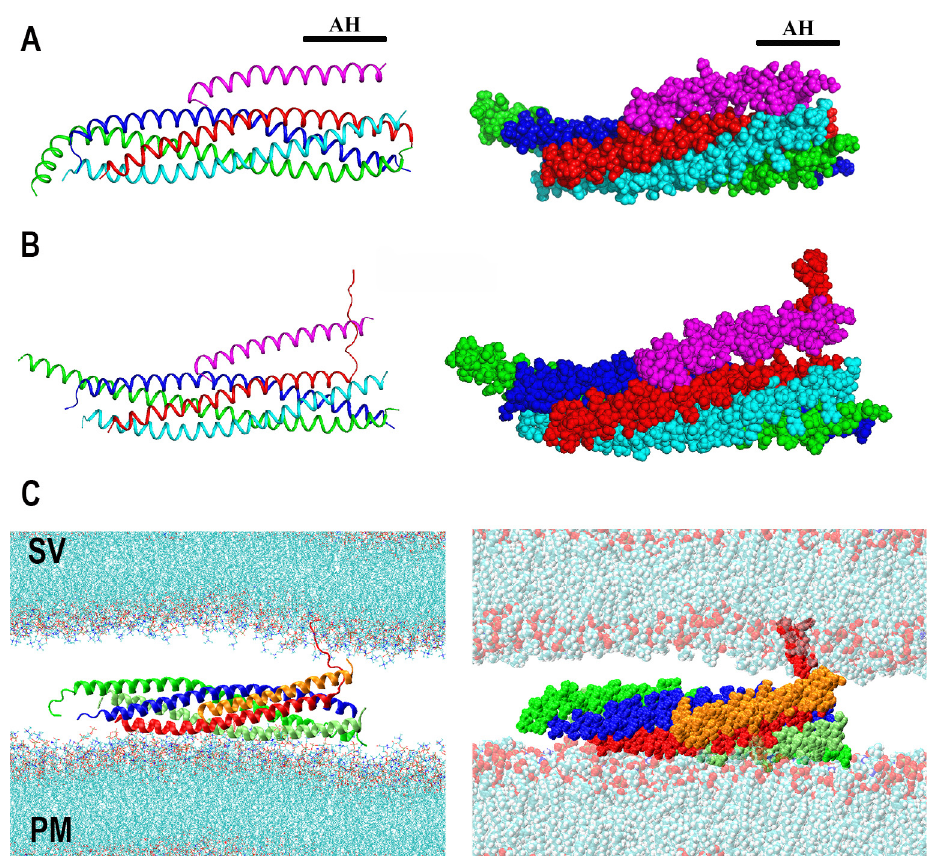
Figure 2. The model of Cpx clamping function driven by AAMD simulations. ( A ) Two representations of the SNARE-Cpx complex. The structure was obtained by crystallography and equilibrated by AAMD. Reproduced from [72]. Blue: Sx; red: Sb; green: SN1; cyan SN2; magenta: Cpx. AH: Accessory helix. ( B ) Cpx stabilizes a partially unraveled state of Sb (Layers 6–8). Reproduced from [75] with permission (license 5472810090395). ( C ) The partially unraveled SNARE complex between lipid bilayers mimicking an SV and the PM. Note that Cpx (orange) creates a barrier between the SNARE bundle and the SV via its accessory helix, in addition to stabilizing the partially unraveled state of Sb.